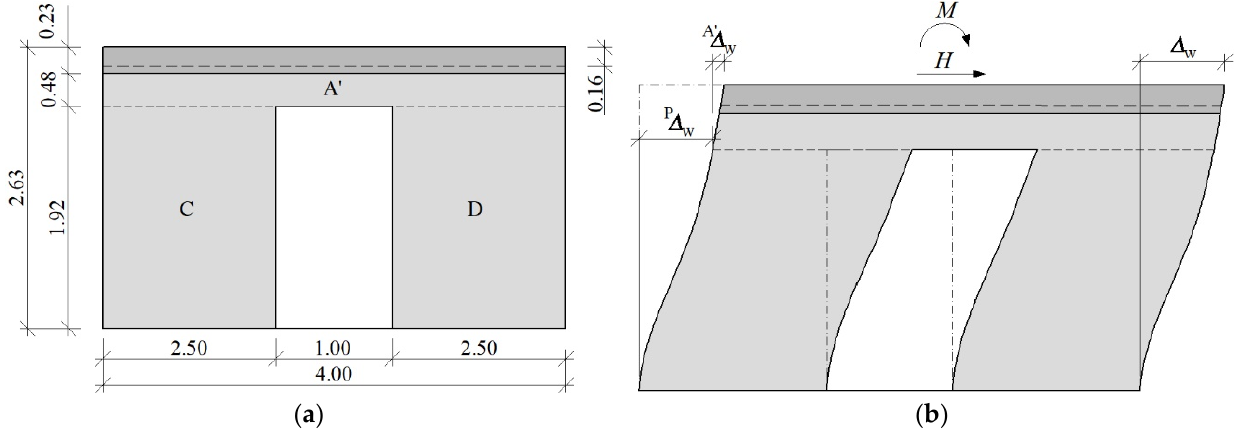
Figure 19. Total wall stiffness method [6]: ( a ) division of a wall with openings into component elements, ( b ) wall deformation caused by horizontal loads. elements, ( b ) wall deformation caused by horizontal